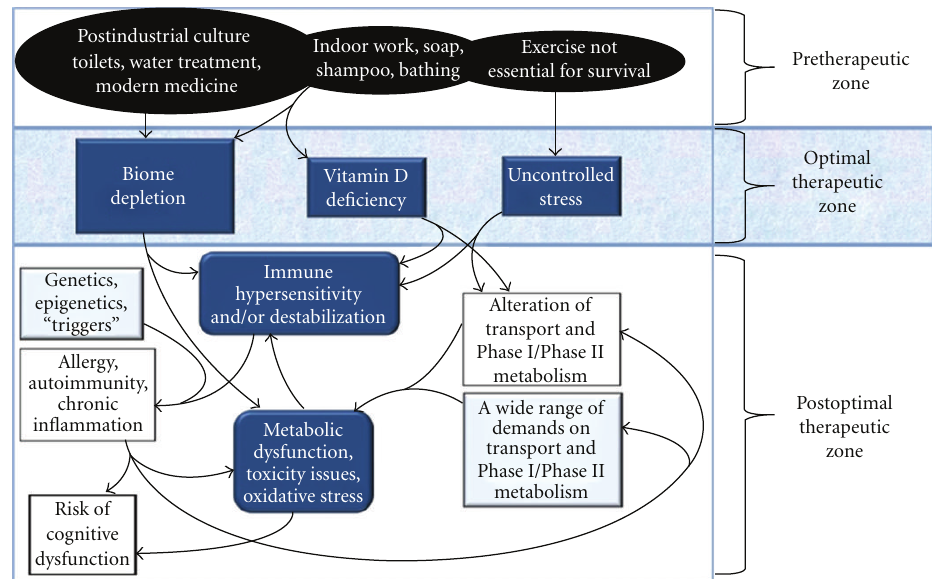
Figure 1: The pathogenesis of epidemics of allergic, inflammatory, and autoimmune disease. Cultural mismatches with human biology (the pretherapeutic zone) have consequences that can be readily avoided (the optimal therapeutic zone). If biome depletion in particular is not avoided, the individual is left susceptible to a wide range of often complex immune-related diseases (the postoptimal therapeutic zone), sometimes associated with imbalances in metabolite transport and/or Phase I/Phase II metabolism. Other consequences such as vitamin D deficiency and uncontrolled stress may, in some but not all cases, add to the problem. Factors contributing to disease which are often naturally occurring and generally di ffi cult or impossible to avoid are underlined and fit within the postoptimal therapeutic